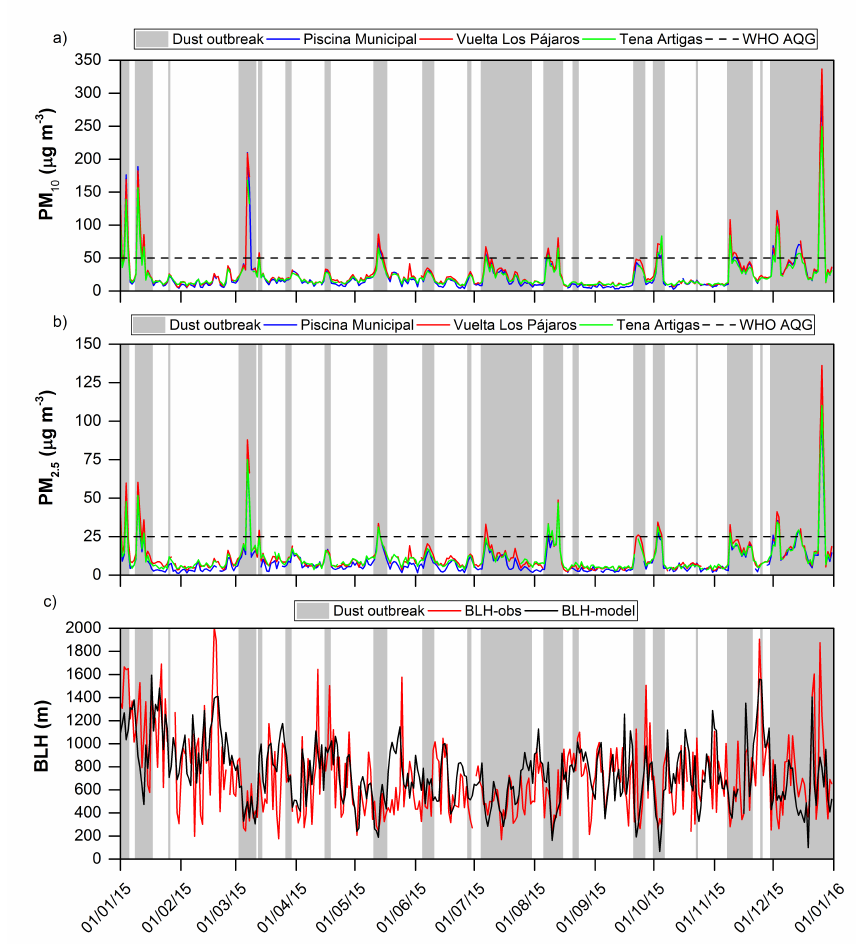
Figure 2. Daily (24-h mean) concentrations of ( a ) PM 10 and ( b ) PM 2.5 at three urban measurement sites in Santa Cruz de Tenerife and ( c ) the boundary layer height (BLH), daily values at 12:00 UTC, obtained from radiosonde observations and from the European Centre for Medium-Range Weather Forecasts (ECMWF) Integrated Forecasting System (IFS) numerical weather prediction model for 2015: Also shown in all panels are the desert dust outbreaks affecting the Canary Islands in